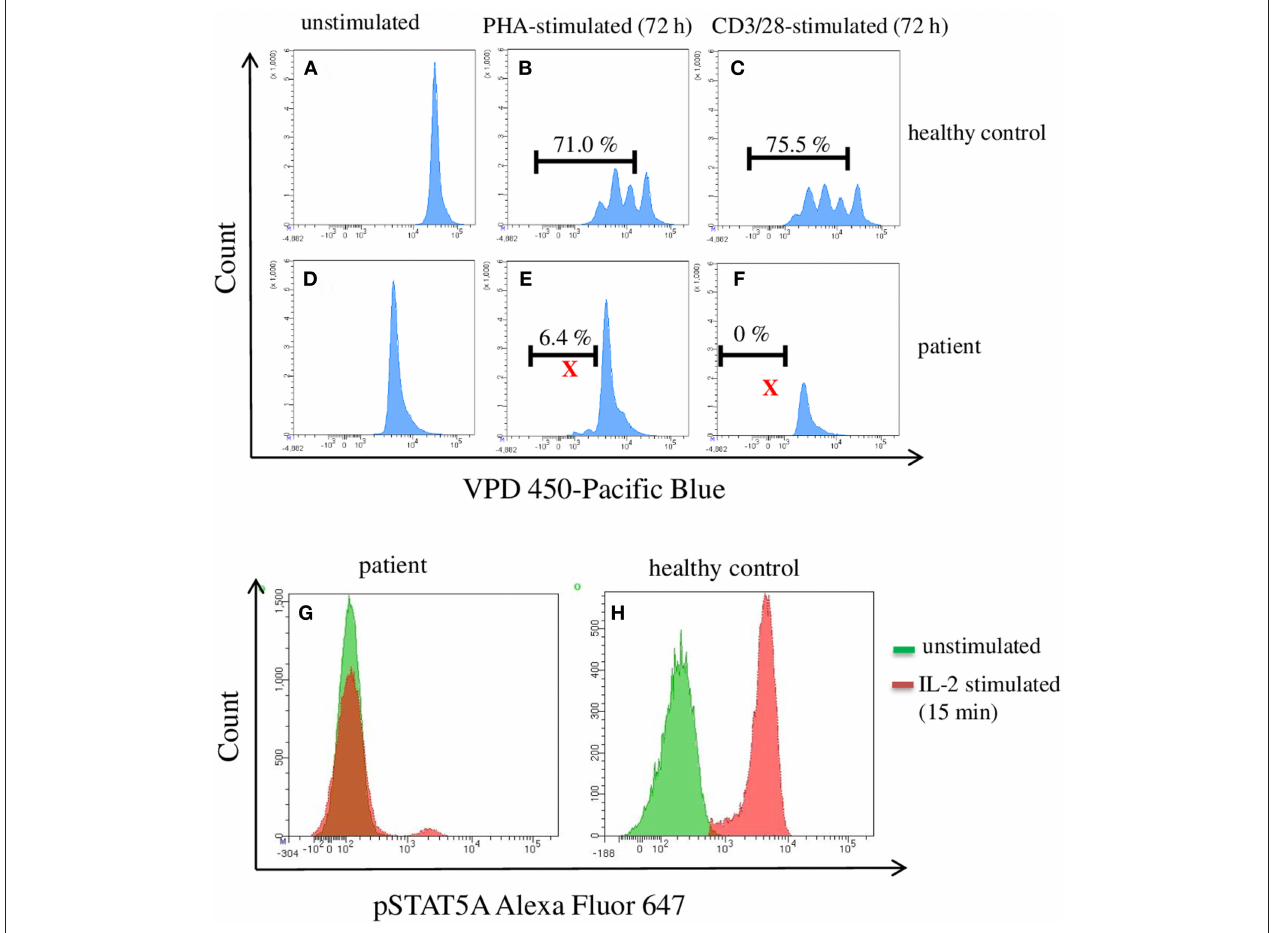
FIGURE 2 | Flow cytometric analysis of pSTAT5A and T cell proliferation in PBMCs from a patient suffering from a congenital pancytopenia. PBMCs (1 * 10 6 cells/ml) were treated with PHA (10 µ g/ml) (B,E) , CD3/CD28 (100ng/ml) (C,F) , or with IL-2 (100ng/ml) (G,H) . After 15min and 72h, IL-2 stimulated pSTAT5A (G,H) and T cells proliferation (A–F) were determined,